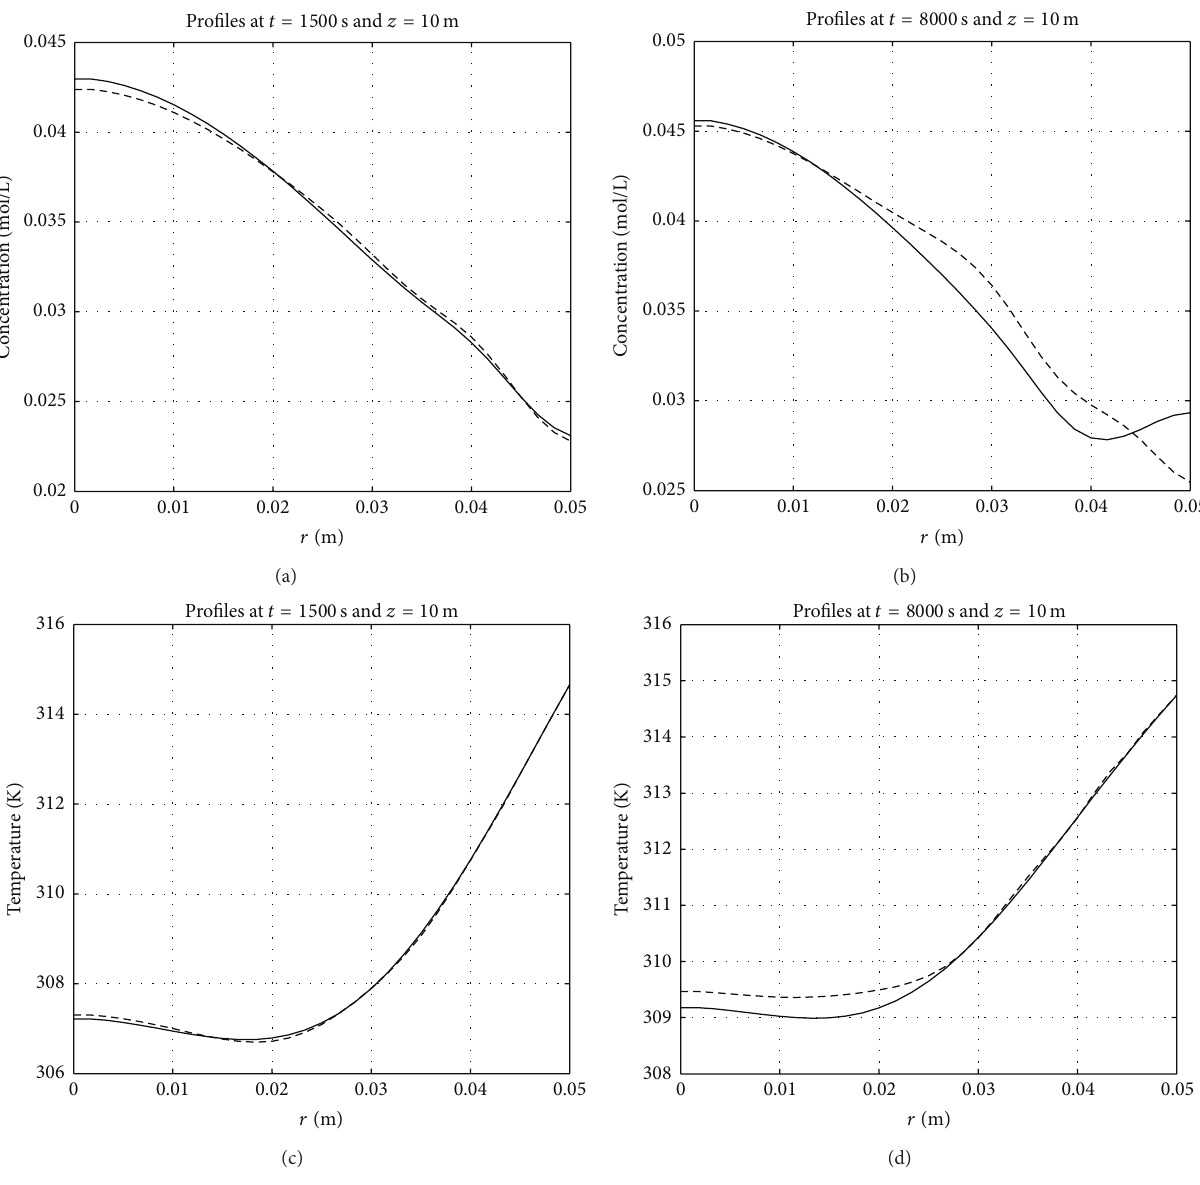
Figure 8: Temperature and concentration profiles at 𝑡 = 1500 s and 𝑡 = 8000 s at 𝑧 = 10 m. Solid line—full-order model. dashed line— reduced-order